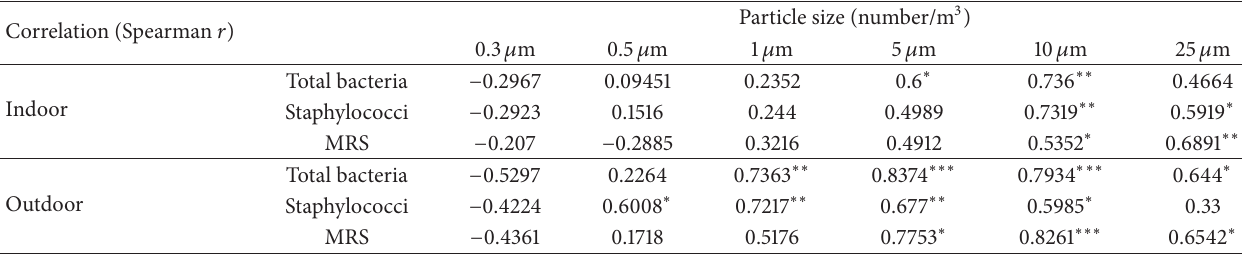
Table 2: Correlation between bacteria and particle